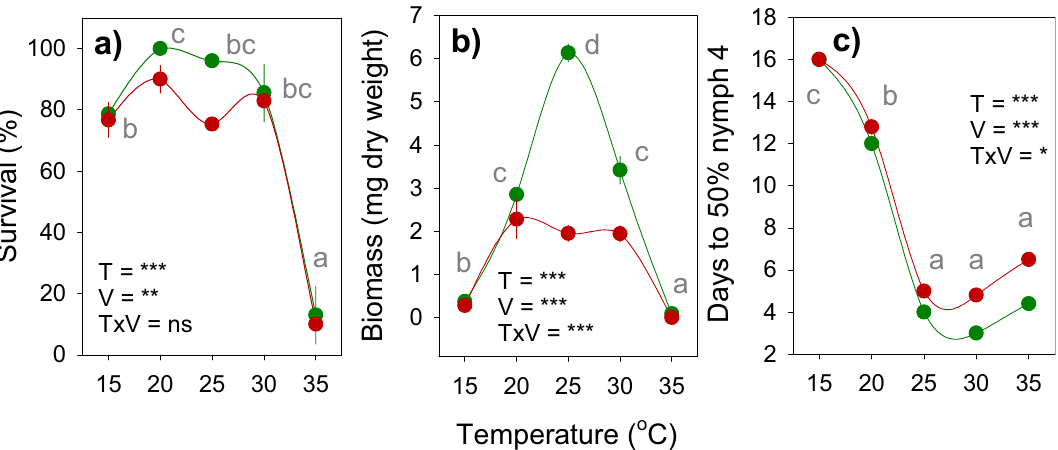
Figure 4. Mean survival, biomass and development of Nilaparvata lugens nymphs on susceptible (IR22: green circles) and resistant (IR62: red circles) rice varieties across a range of temperatures. Nymph survival at the end of 15 days is indicated in a . The biomass of surviving nymphs ( b ) and the time for 50% of nymphs to develop to fourth instars ( c ) are also indicated. Numbers are based on accumulated data over 15 days of the experiment (23 and 30 days for nymph development at 20 °C and 15 °C, respectively). Relative humidity was maintained at 80%. Bars indicate standard errors (N = 5). Effects of variety (V), temperature (T) and their interaction (V × T) are indicated as ns ( P > 0.05), * ( P ≤ 0.05), ** ( P ≤ 0.01), *** ( P ≤ 0.005); lowercase letters indicate homogenous temperature groups (Tukey, P ≤ 0.05).